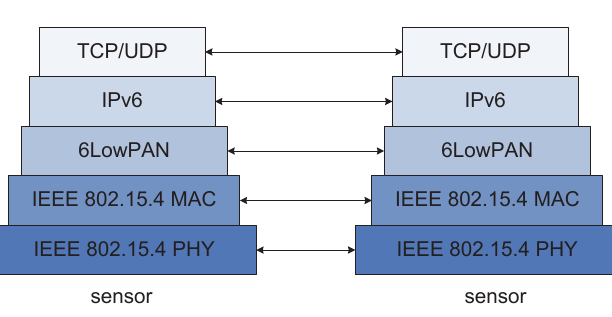
Figure 1. The position of 6LoWPAN in the IPv6 protocol stack the maximum frame size supported by IEEE